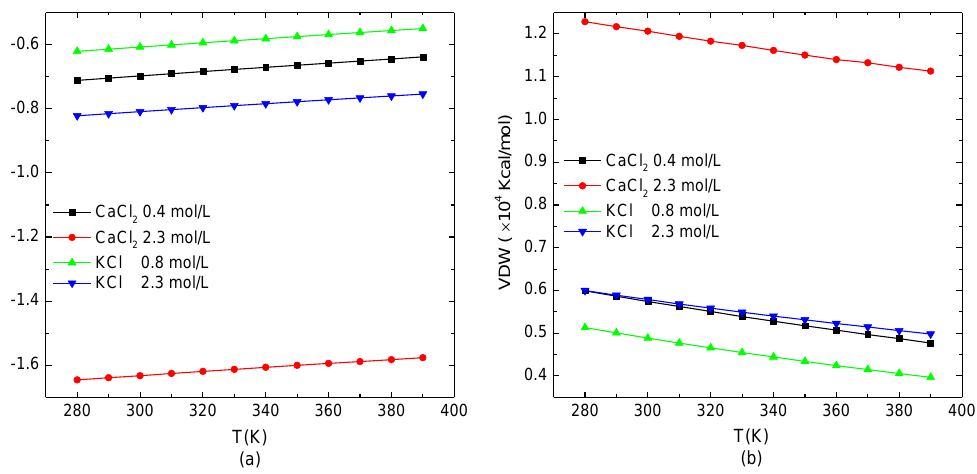
Figure 4. The non-bonded interactions of the protein system versus the temperature. ( a ) Electrostatic potential energy and ( b ) van der Waals energy.